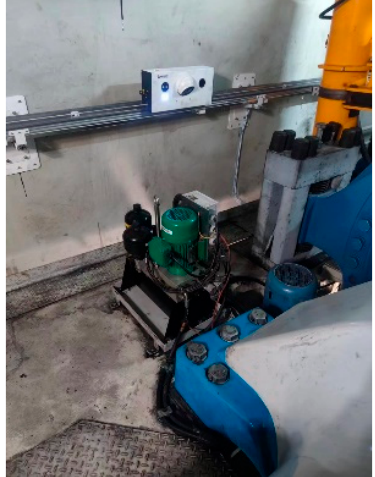
Figure 1. Inspection robot inside the wind turbine nacelle.